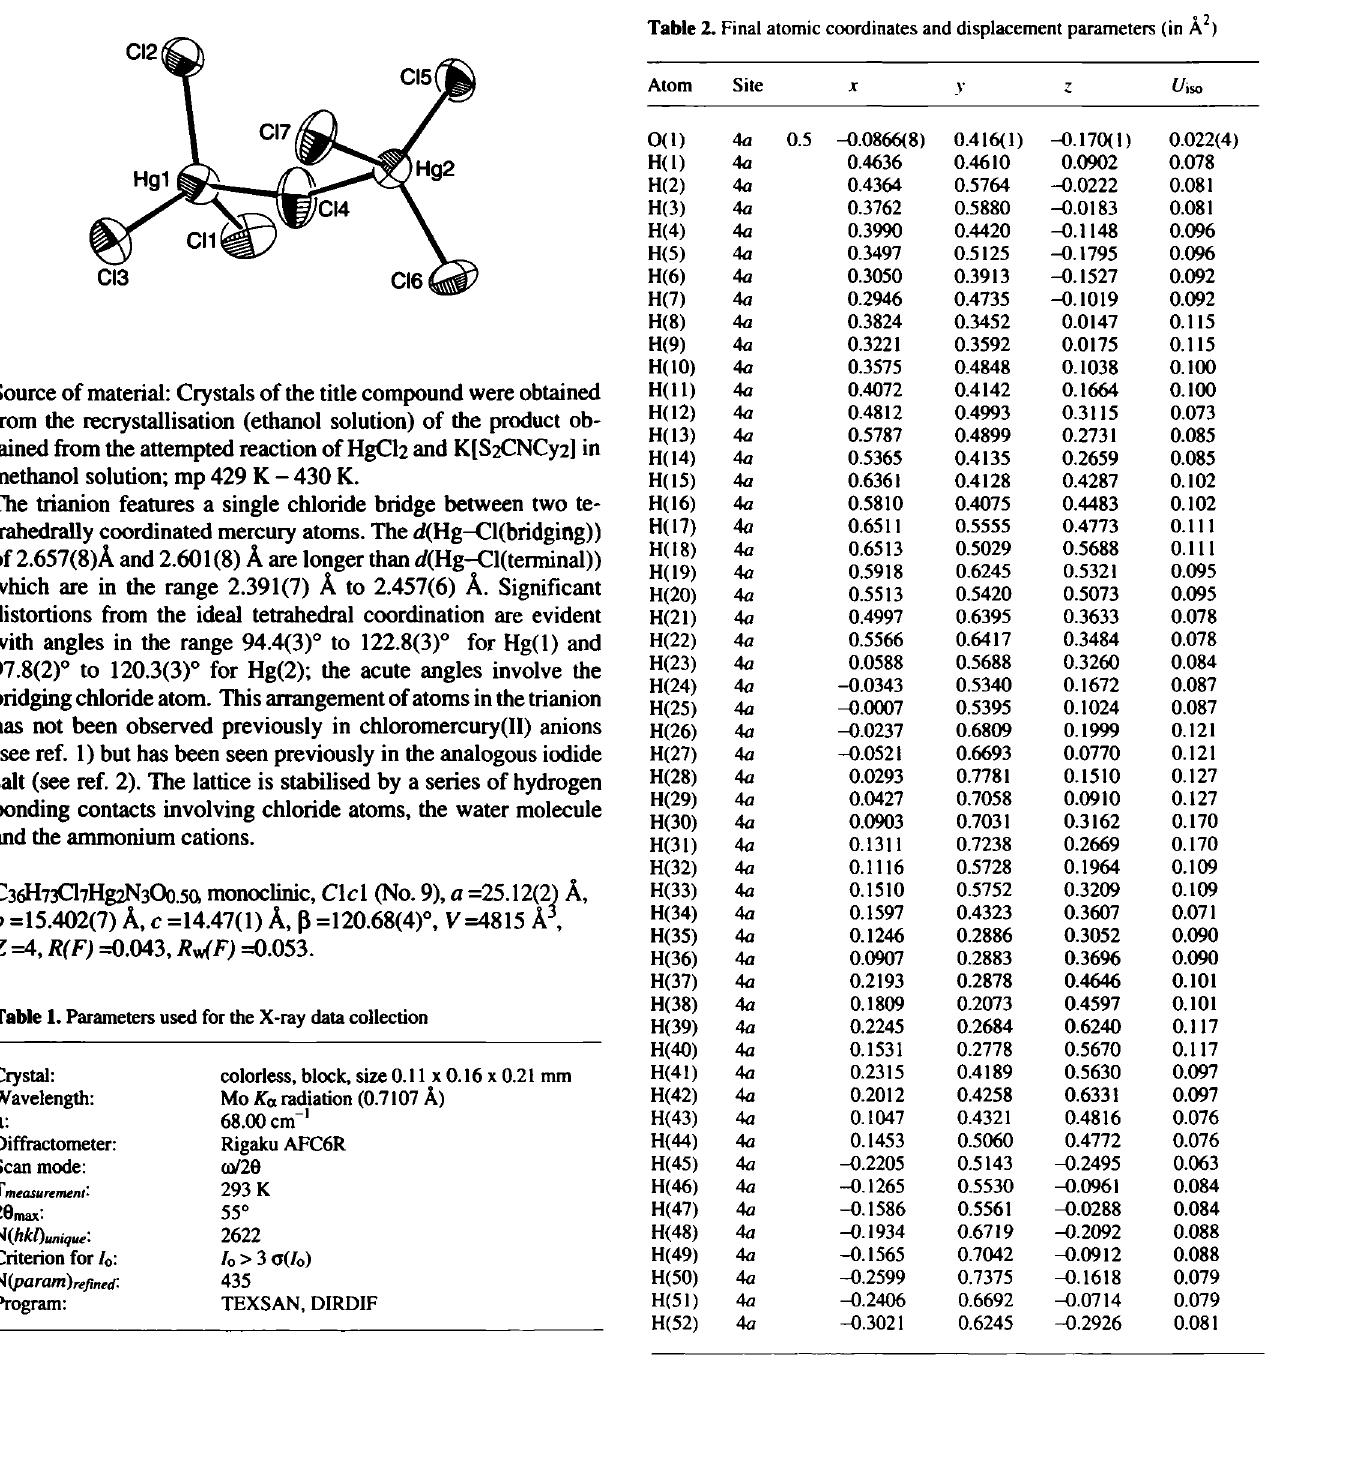
Table 1. Parameters used for the X-ray data collection Crystal: